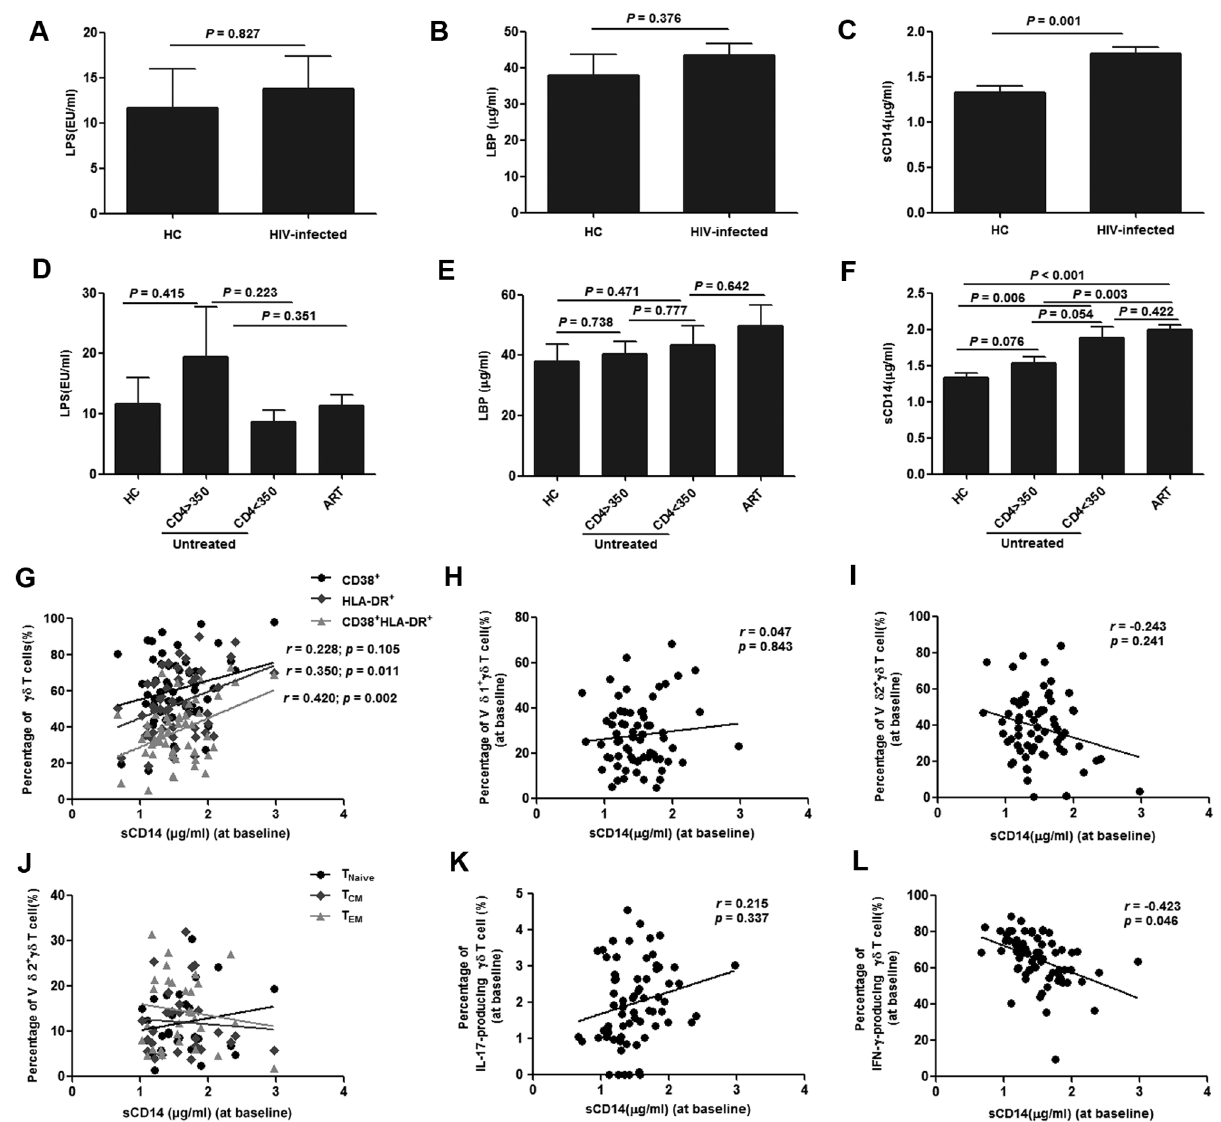
Figure 6. Correlation between microbial translocation and cd T cells. Levels of LPS, LBP and sCD14 were analyzed in healthy controls (HC) and acutely HIV-infected subjects at baseline ( A–C ). The patients were then subdivided based on the administration of antiretroviral therapy (ART) and CD4 levels ( , or . than 350/ m L). The levels of LPS, LBP and sCD14 were re-analyzed and compared with HC ( D–F ). Correlation analysis between the proportion of activated cd T cells determined by CD38 + , HLA-DR + or CD38 + /HLA-DR and sCD14 levels at baseline was performed by Spearman’s rank correlation, where coefficients ‘r’ and corresponding P -values are indicated on panel G. Similar correlation analysis was performed between sCD14 levels and different subsets of cd T cells [V d 1 ( H ) and V d 2 ( I )], subgroups of V d 2 cells (Tnaı¨ve, TCM and TEM) ( J ), IL-17-producing cd T cells ( K ) or IFN- c -producing cd T cells ( L ).